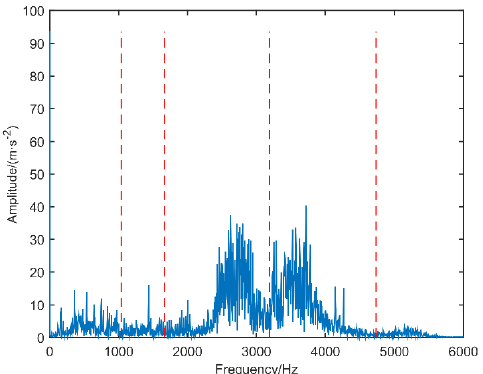
Figure 5. The spectrum segmentation result of motor bearing inner race.